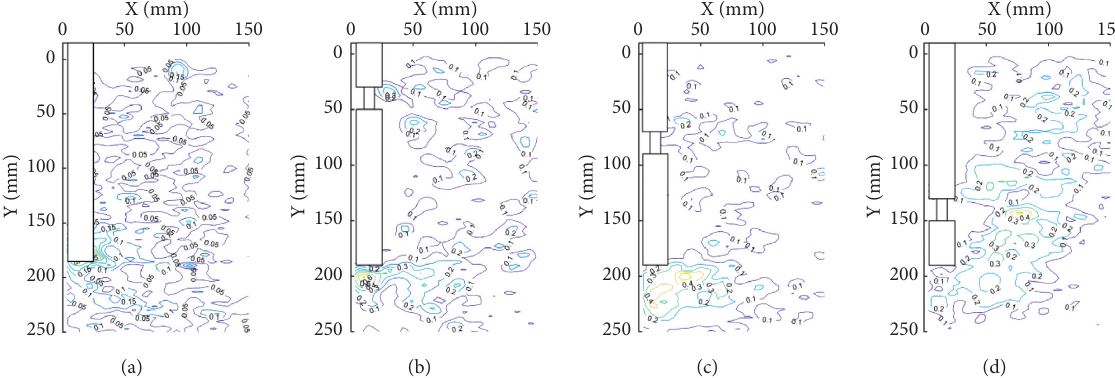
Figure 12: Displacement contour map of soil around the single pile under 260N load level. (a) Intact pile. (b) Necking in the shallow pile body. (c) Necking in the middle pile body. (d) Necking in the deep pile